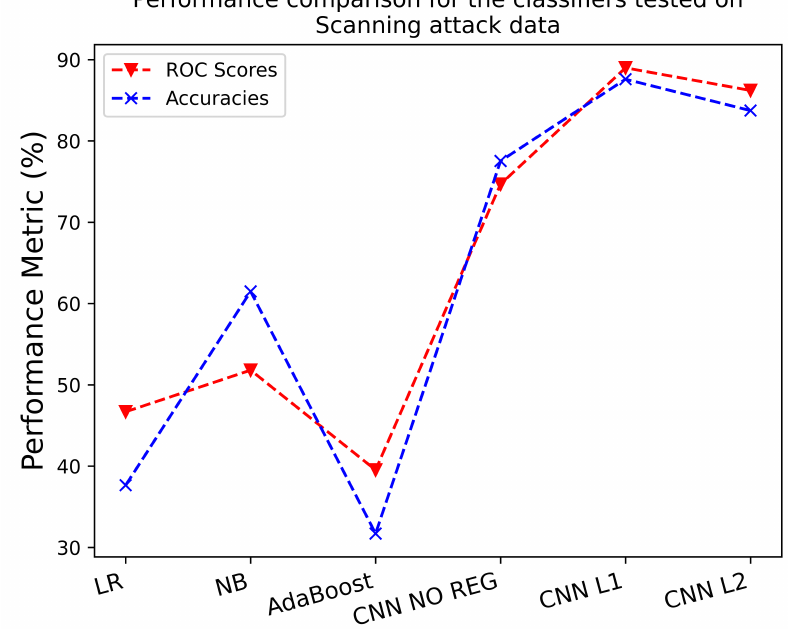
Figure 6. Performance metrics comparison for Scenario